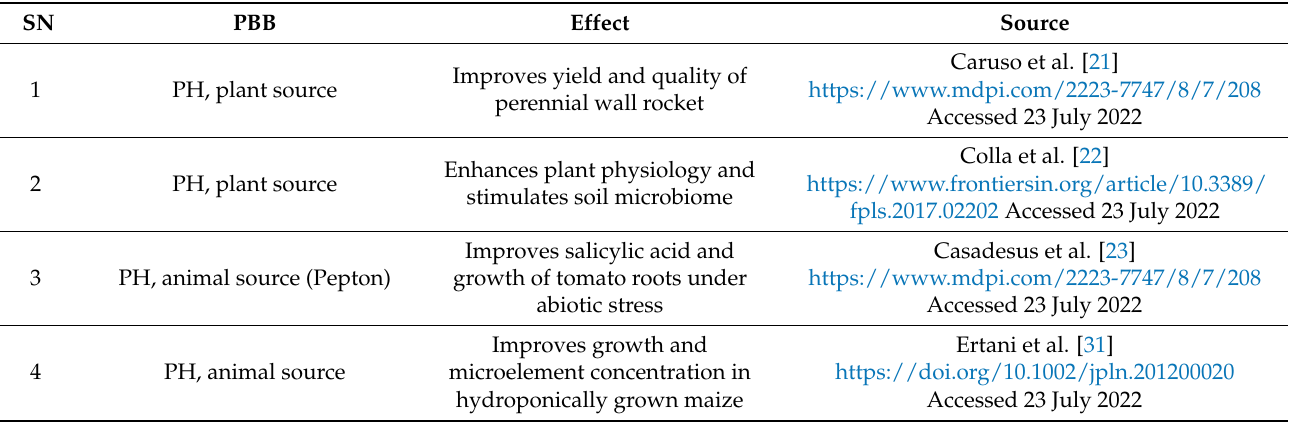
Table 1. Reported effect on crop performance of different protein hydrolysates (PHs) used as protein- based biostimulants